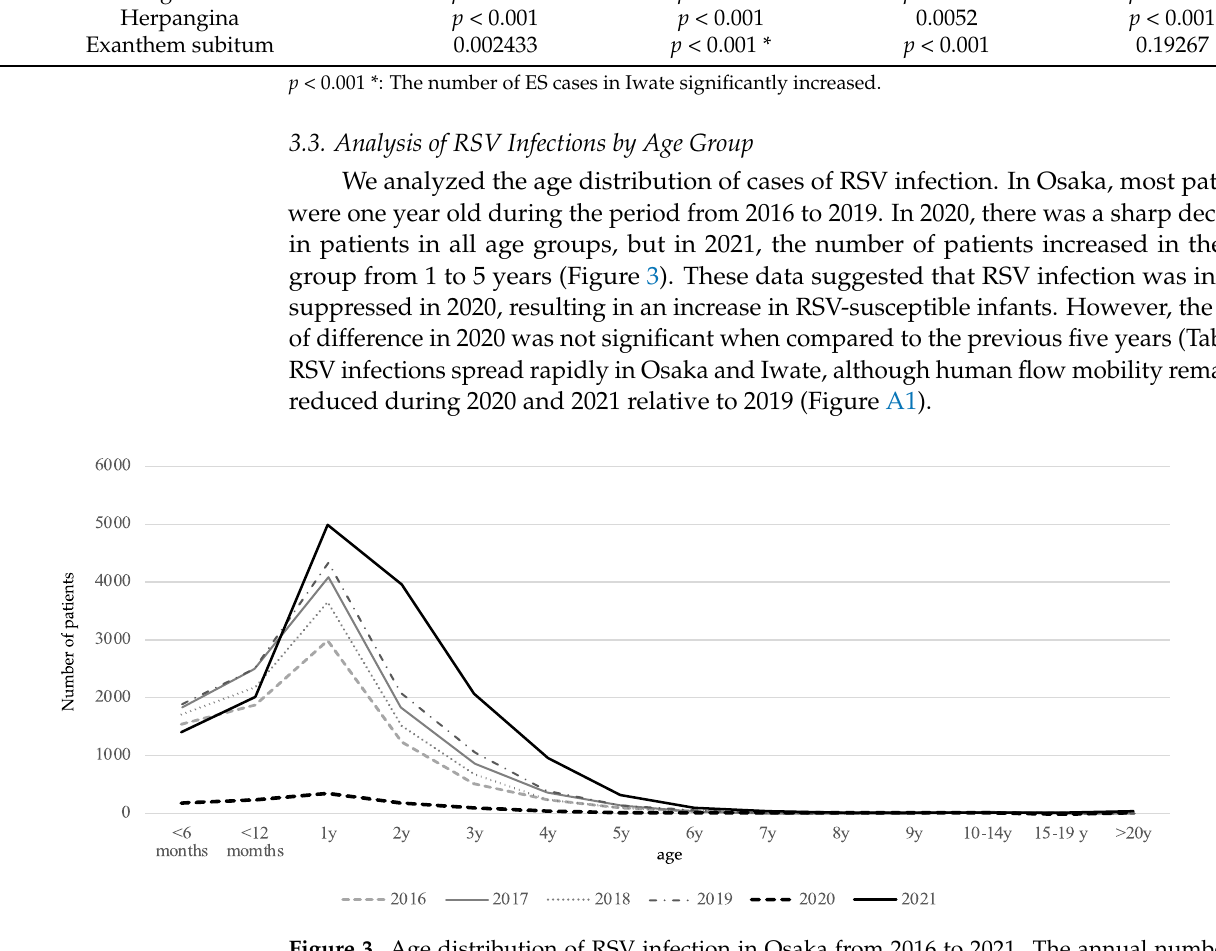
Figure 3. Age distribution of RSV infection in Osaka from 2016 to 2021. The annual numbers of reported patients were 8542, 11,675, 10,174, 12,478, 1129, and 15,915 for each year from 2016 to 2021, respectively.